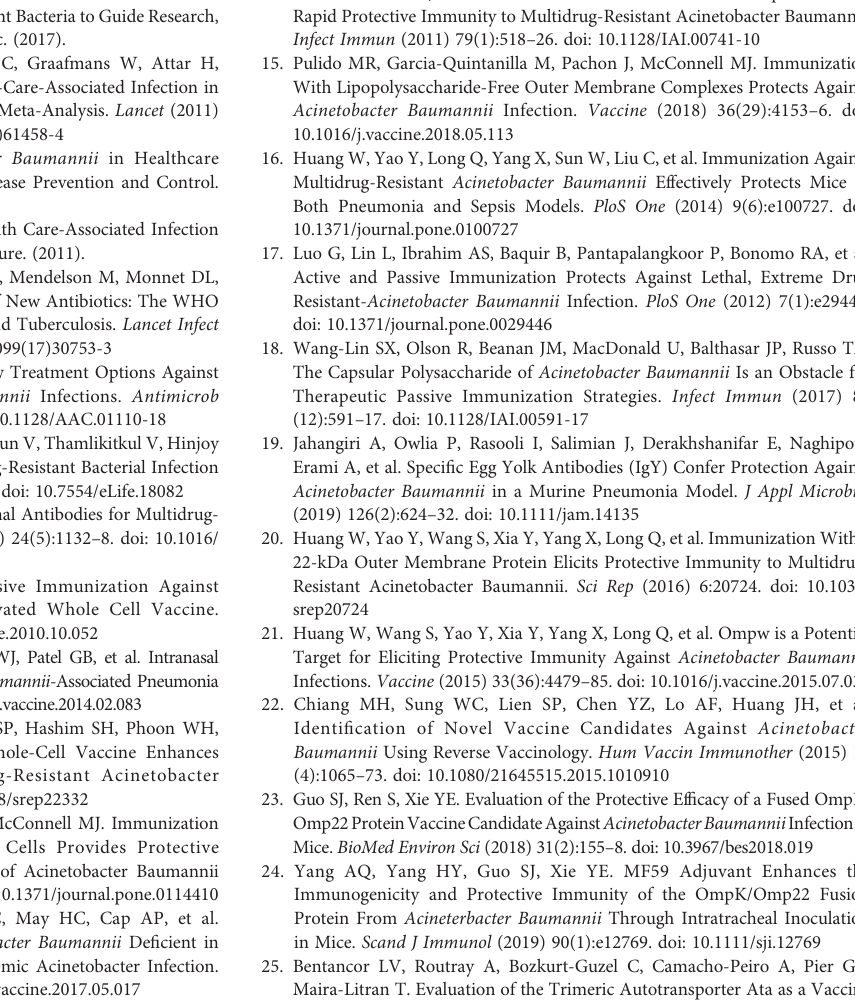
immunized mice (grey line, solid circle) (B) and the OD 600nm measured every 30 minutes over 24 hours. Supplementary Figure 2 | Growth inhibitory activity on a panel of four A. baumannii isolates by mouse antisera. 10 2 CFU of a panel of A. baumannii isolates were incubated in triplicate with either AB3879 antisera (left panel) or multi strain antisera (right panel) and the OD 600nm measured every 30 minutes for 24 hours. Sera from non-immunized mice was included as a control (open symbols). Solid symbols represent respective anti- A. baumannii antisera. Data from two independent experiments is shown. The fi ve isolates are grouped by their capsule serotype and indicated at the top of each graph in brackets. Round, square and triangle symbols represent ST2, ST215, and ST164 MSLT types respectively. Supplementary Figure 3 | Bacterial load in the spleen, liver and lungs from mice following lethal challenge with homologous AB3879 strain. CD1 mice were immunized three times with 10 6 CFU of the AB3879 or PBS followed by IP infection with2.0x10 7 CFU/mouse of the homologousAB3879 strainin abacteremia model of infection. The bacterial burden in the spleen, liver and lungs were determined 24 hpi. Dotplots represent individual valueswith lines indicating the mean and the error bars indicate standard deviations (SDs) (n=15/group) Mann-Whitney U-test was used for statistical analysis *p-value < 0.05, **p-value< 0.001, ***p-value < 0.0001, ns: p-value= not signi fi